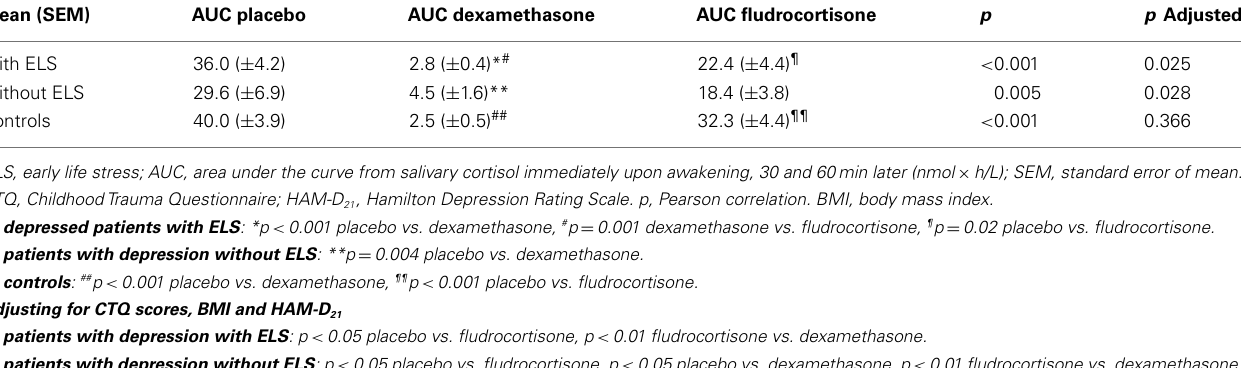
Table 2 | Cortisol awakening response (measured as area under the curve) after placebo, dexamethasone, and fludrocortisone in depressed patients with or without early life stress and controls; and adjusting for CTQ scores, BMI, and HAMD- 21 . Mean (SEM)